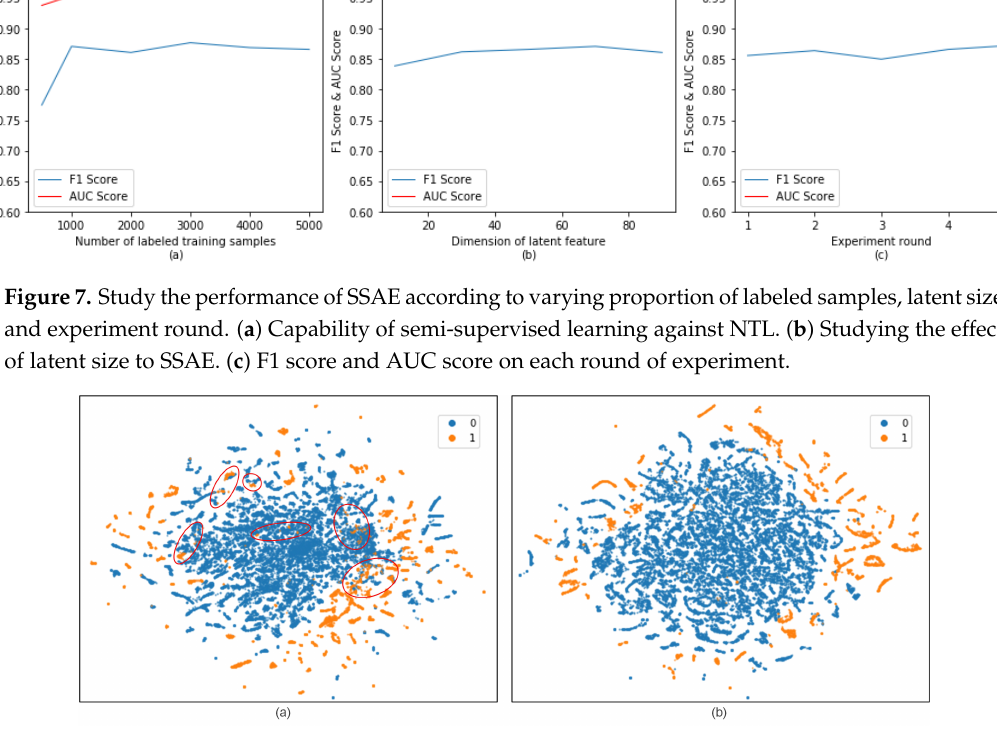
Figure 8. Comparison of t-SNE results of original samples and features learned by SSAE where 0 denotes normal samples plotted in blue, and 1 denotes NTL samples plotted in orange. ( a ) Original samples with embedding knowledge. ( b ) Latent features learned by SSAE.